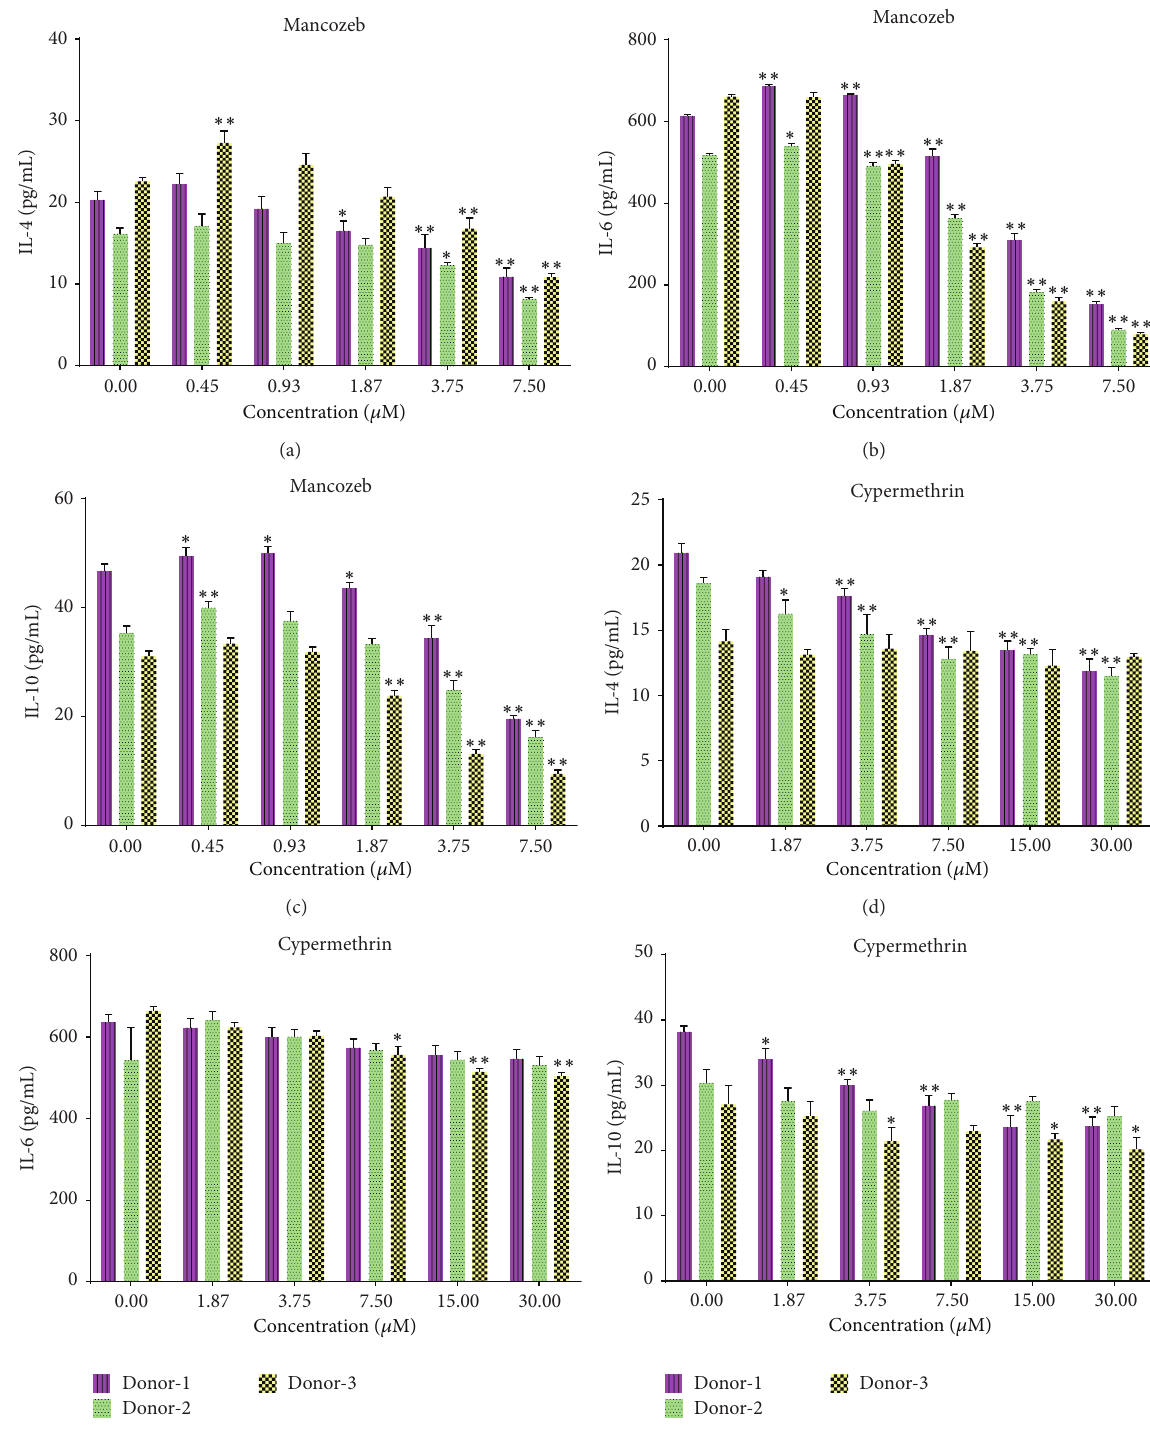
2 cytokine profiles. Effect on T 2 cytokines IL-4, IL-6, and IL-10 production in PBMC cultures. Mancozeb: (a) IL-4; (b) IL-6; Figure 4: T H H and (c) IL-10. Cypermethrin: (d) IL-4; (e) IL-6; and (f) IL-10. Values shown are mean ( ± SE) from triplicate samples conducted with PBMC from three volunteers. ∗ 𝑃 < 0.05 ; ∗∗ 𝑃 < 0.01 versus zero control. For each donor, statistical analyses performed across the doses showed that resultant IL-6 values were consistently significantly different as a function of dose in the mancozeb study. Further, in that same study, IL-10 values were also consistently significantly different as a function of dose for doses of ≥ 0.93 𝜇